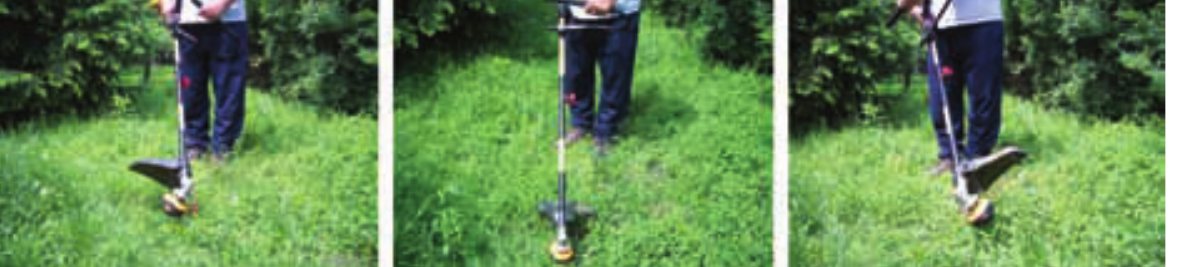
Figure 3. The three holding positions of the tool